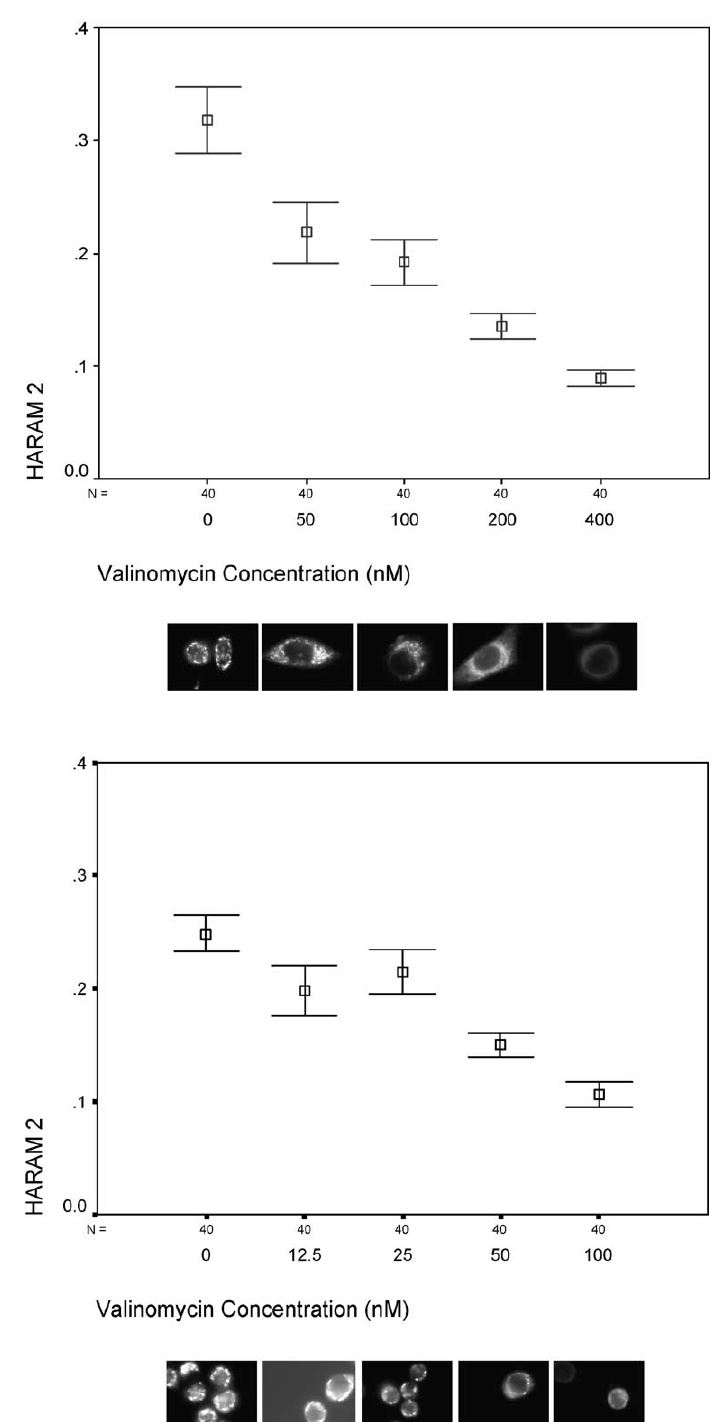
Fig. 1. HARAM 2 texture feature for (a) SW480 cells and (b) SW620 cells demonstrating decreasing trend in HARAM 2 value with depolarisation of ∆ ψ m and change in appearance of the